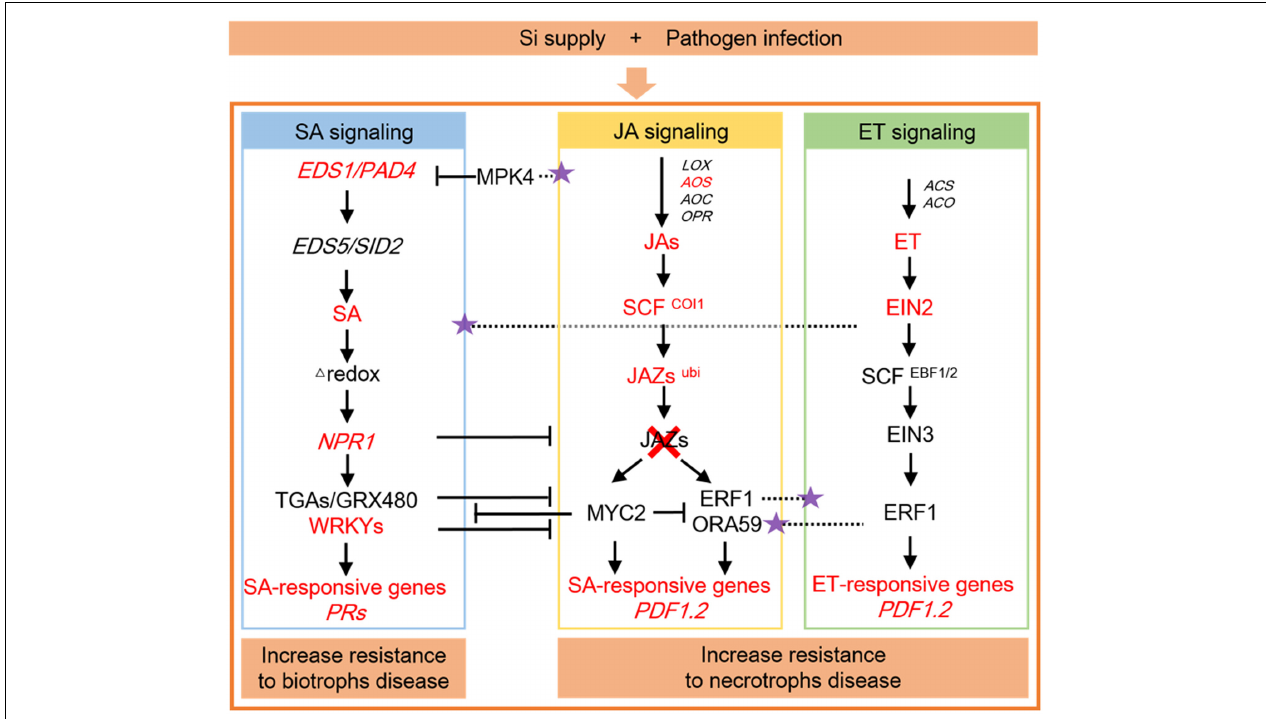
FIGURE 2 | Signaling pathways in the plant defense response regulated by silicon (Si). Crosstalk between signaling pathways in plant defense originating from the actions of salicylic acid (SA), jasmonic acid (JA), and ethylene (ET) are demonstrated, as well as their interactions in modulating the defensive response regulated by Si. The SA signaling pathway mainly involves in biotrophs disease, whereas JA and ET signaling pathways attribute to necrotrophs disease. T, negative effect; purple stars, positive effect; red, increased or up-regulated by Si supply. The networking of signaling pathways are modified from Pieterse et al.